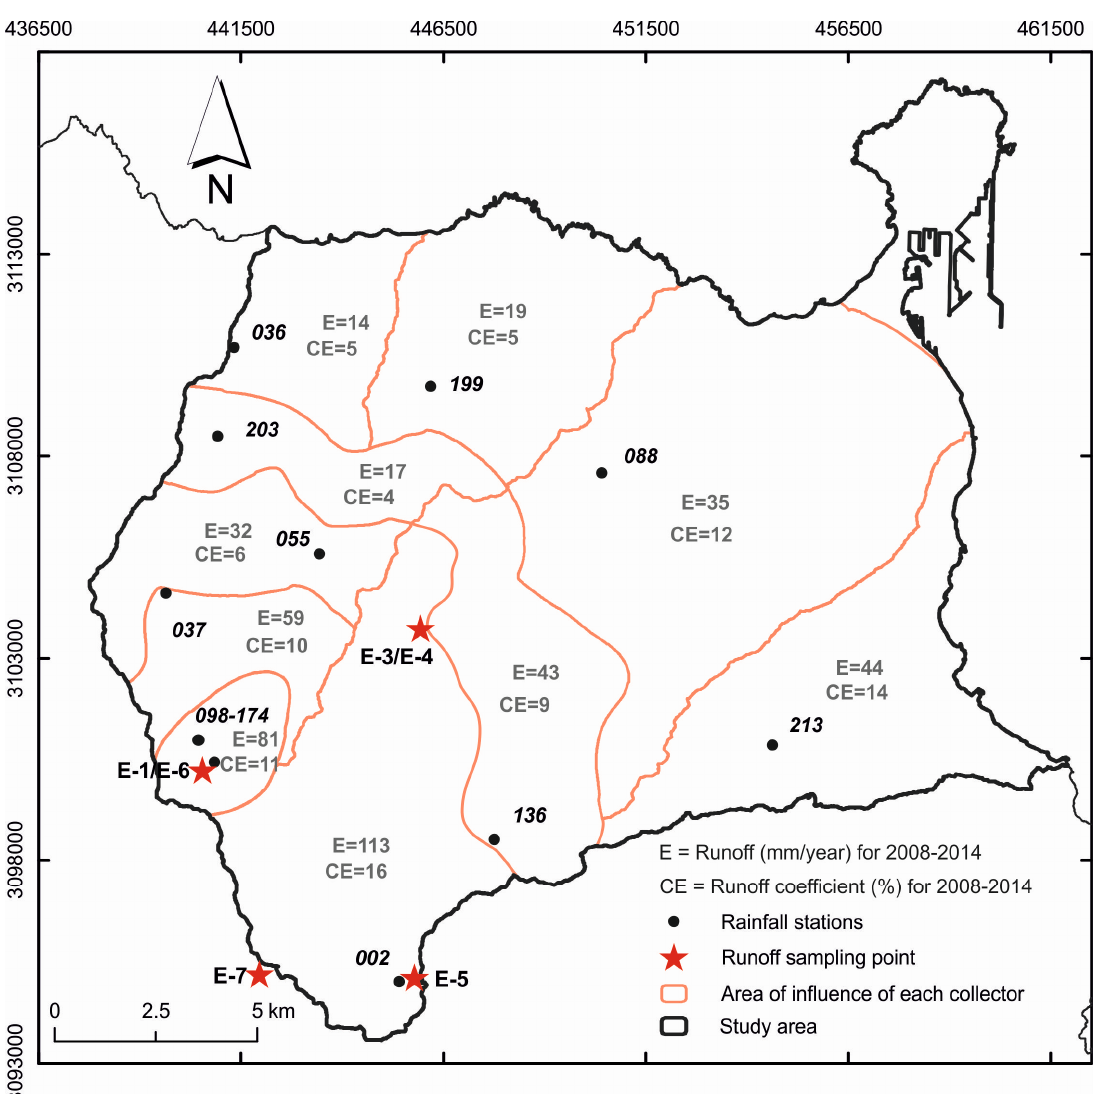
Figure 2. Area of influence of each collector and spatial distribution of the estimated runoff and runoff coefficients for 2008–2014, modified from [33]. Bold - italic numbers correspond to the rain-gauge station code (rain